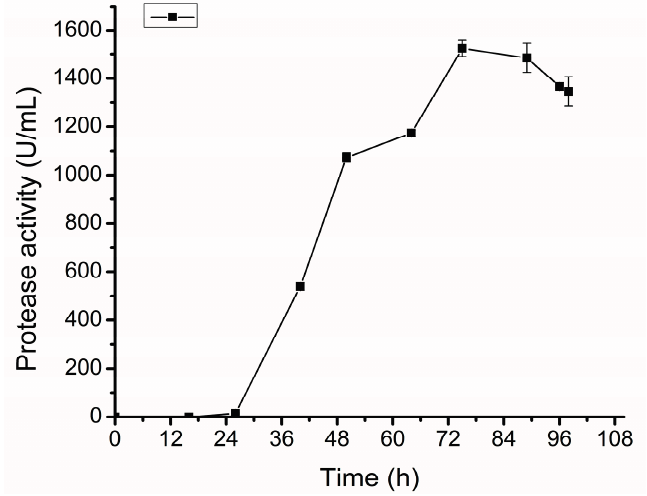
Figure 4. The protease production of D25 in a 7.5 L fermentor under the determined small scale fermentation process. The graph shows data from triplicate treatments (mean ±